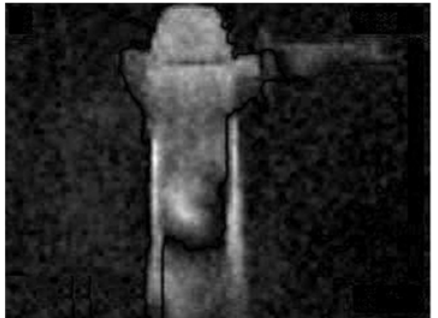
Figure 10. Difference of thermal images: | ag1b ‐ ag2b| , where ag1b − matrix (320 × 240) of the thermal image of the angle grinder with 1 blocked air inlet, ag2b − matrix (320 × 240) of the thermal image of the angle grinder with 2 blocked air inlets. The next step was binarization of computed differences. Threshold was equal to 0.1